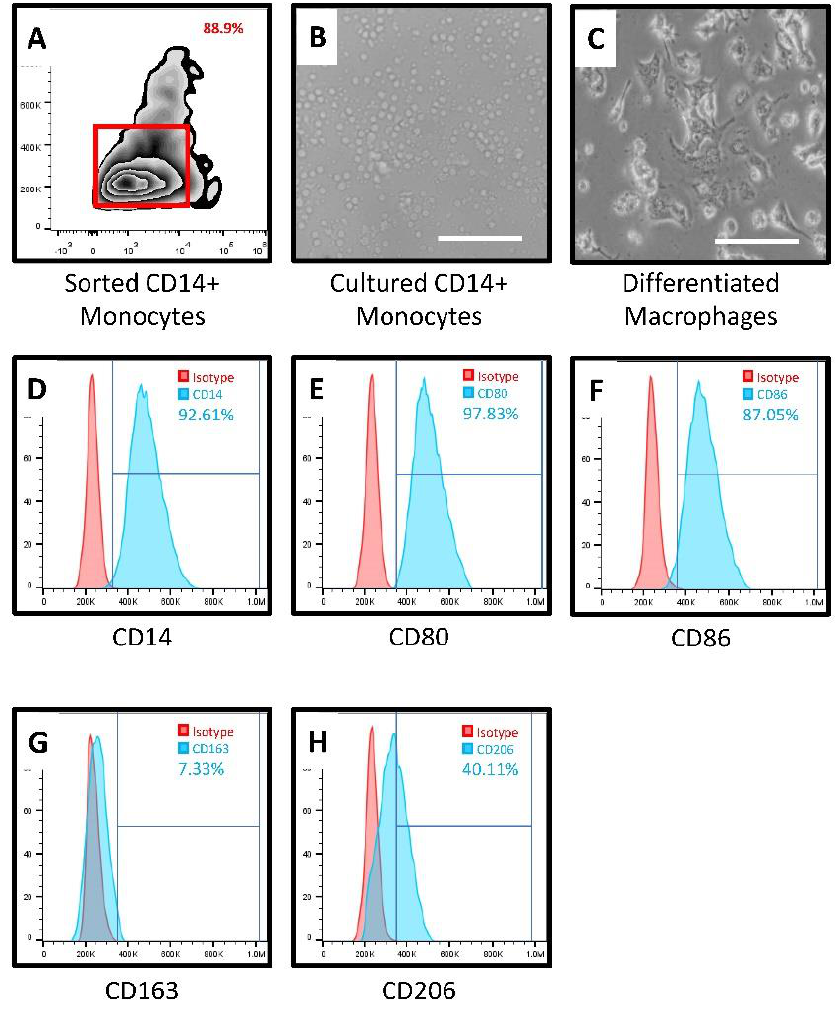
Figure 2. ( A )—CD14+ monocyte sorting; ( B )—Cultured CD14+ monocytes; ( C )—GCF treated CD14+ monocytes differentiating into macrophages; Cell surface analysis of the differentiated macrophages with ( D )—CD14, ( E )—CD80, ( F )—CD86, ( G )—CD163, ( H )—CD206